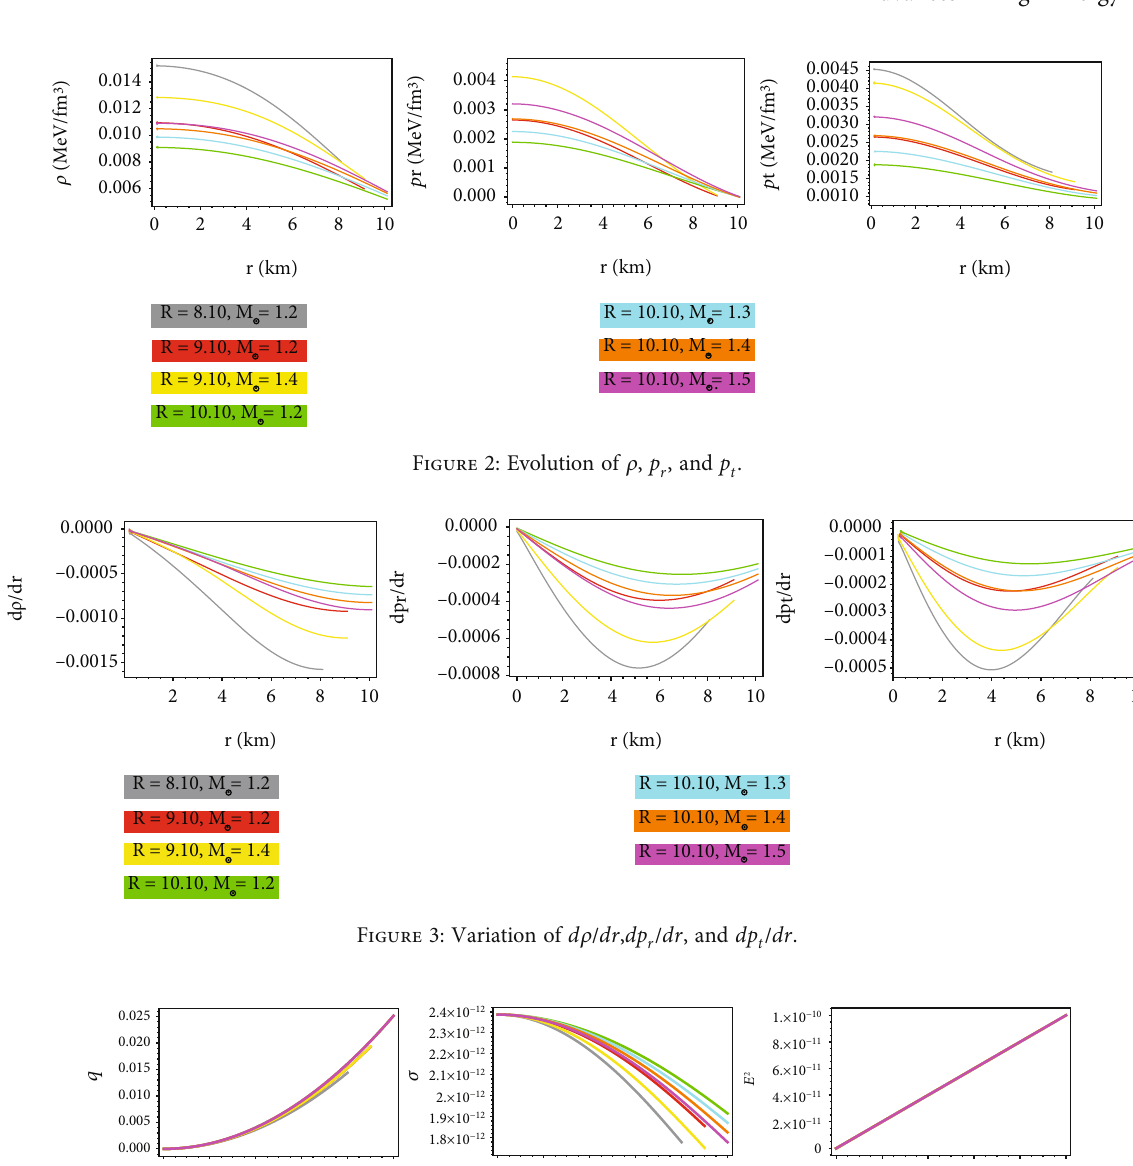
Figure 3: Variation of d ρ / dr , dp